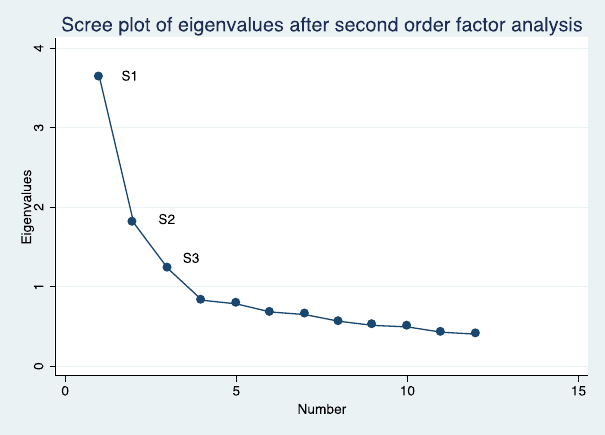
Figure 2. Scree plot for second-order factor analysis.